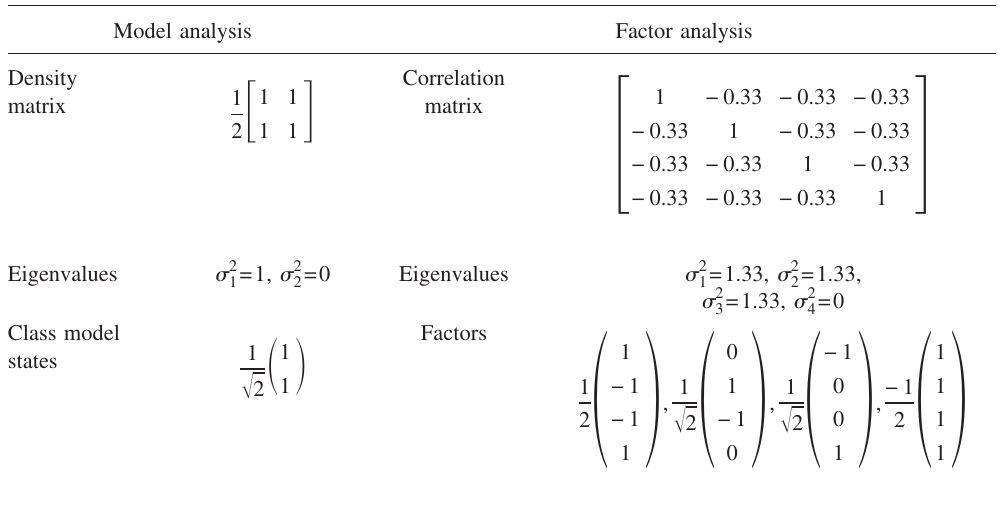
TABLE IV. Results from model analysis and factor analysis for a class having a single population with an equally mixed model state.